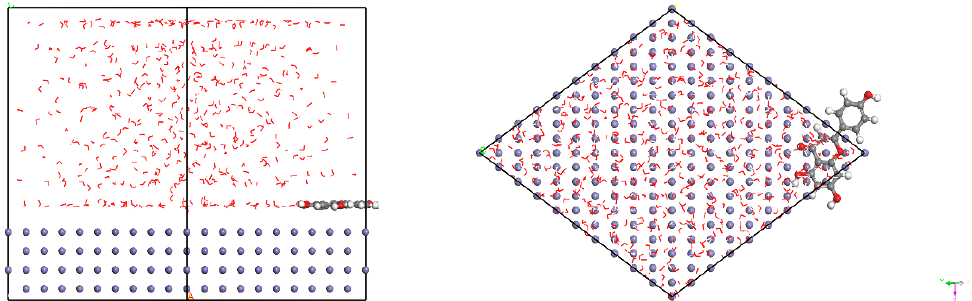
Figure 13. The adsorption configuration of luteolin molecule on Fe (110) surface.